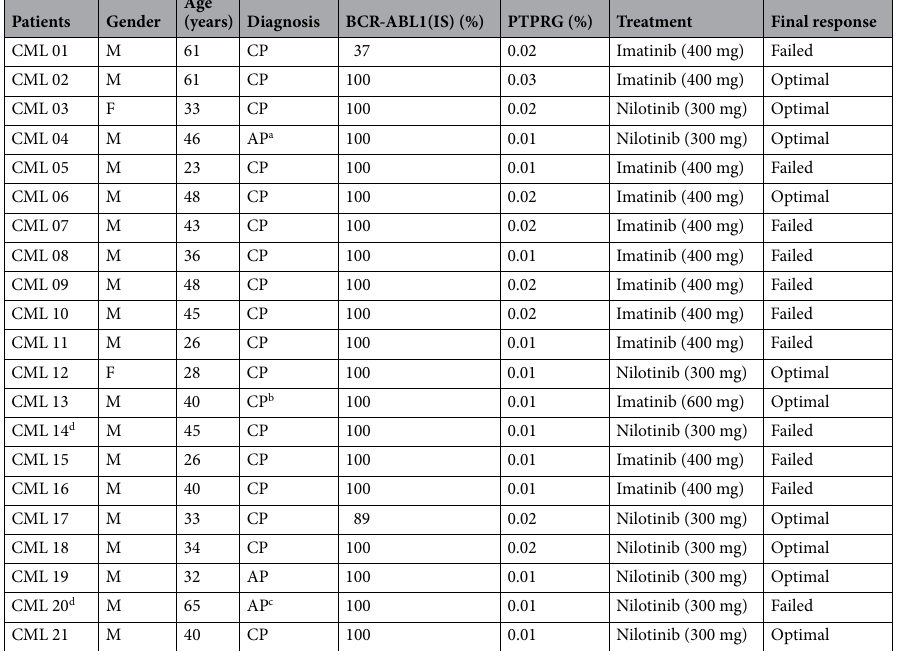
Table 1. CML patient’s characteristics: gender, age, clinical phase, TKIs (BCR/ABL1 and PTPRG) at diagnosis stage and response to treatment. a CML04 AP with additional chromosomal t(9:22) (q34, q11.2); t(11; 14) (q23, q32) (30). b CML13 CP with Tuberculosis. c CML20 AP with double Ph + . d CML14 patient lost to record myeloid lineage events at time of